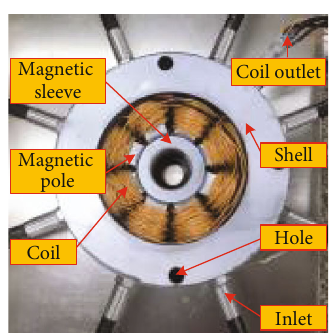
Figure 3: Real products of radial